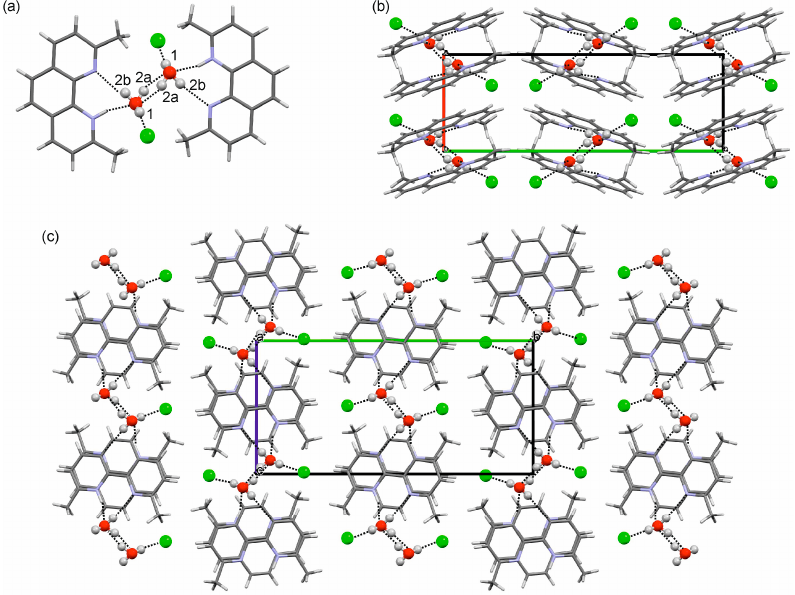
Figure 10. H-bonding and packing diagrams of 2-Hy1 : ( a ) Water proton disorder; ( b , c ) Packing diagrams in ( b ) viewed along the crystallographic c and in ( c ) along a axis. Dotted lines indicate H-bonding interactions.